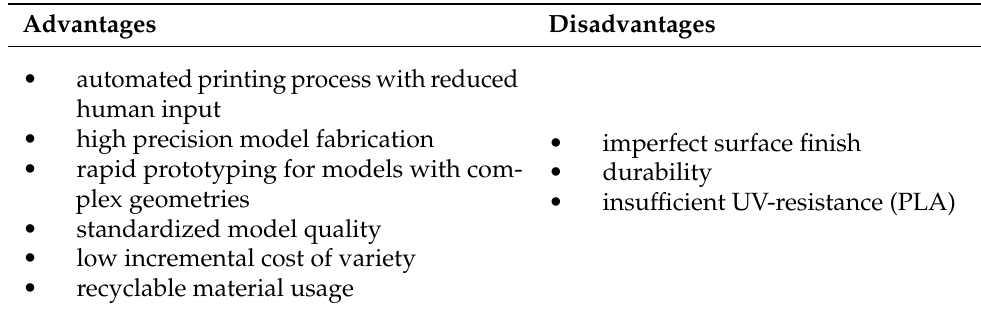
Table 3. Advantages and disadvantages of 3D printing relative to conventional fabriacation methods.